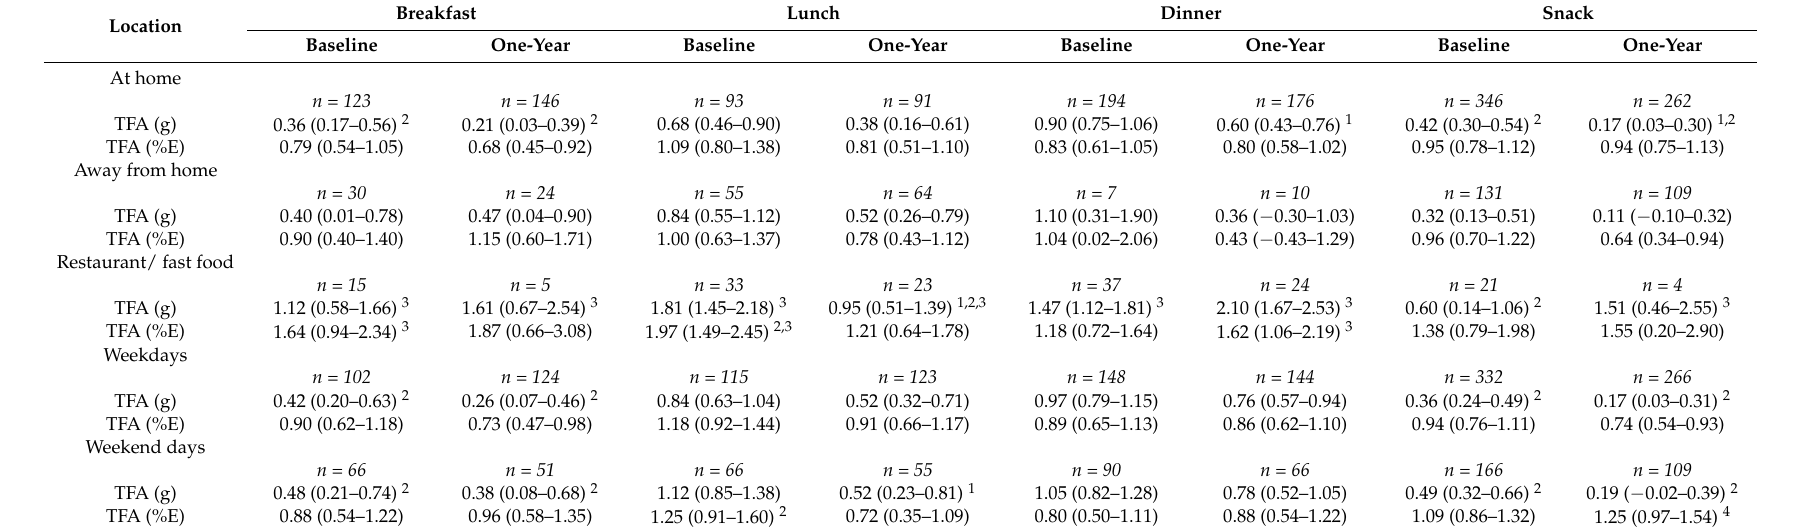
Table 5. TFA intake by meal type, weekday and location at baseline and one